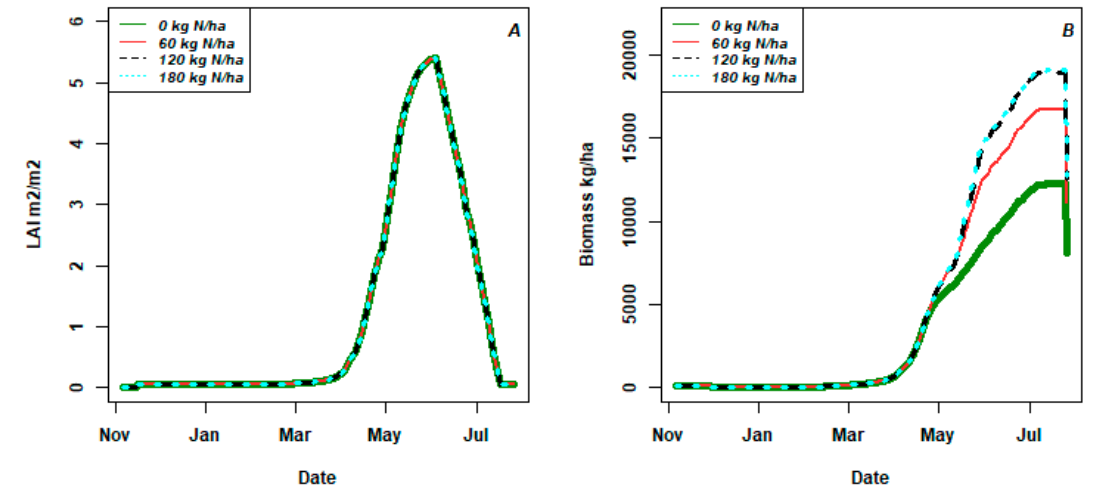
Figure 7. LAI ( A ) and biomass ( B ) curves obtained with default LAI parameters for the four different fertilization management treatments (0, 60, 120, and 180 Kg N/ha) in 2016. The graphs show a variation in the biomass levels but not in LAI.3.4. Yield Estimation for 2017.